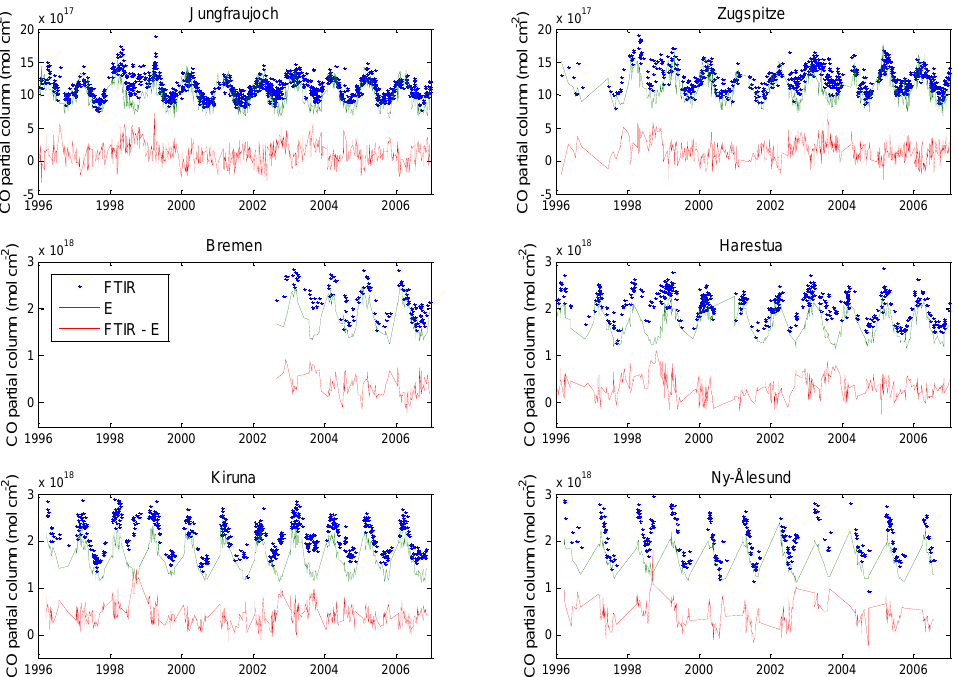
Figure 1. CO comparison between European EMEP model (E) and FTIR measurements. The measurements are marked as dots and the model is marked as a solid green line. The difference between measurements and model is marked as a red solid line.